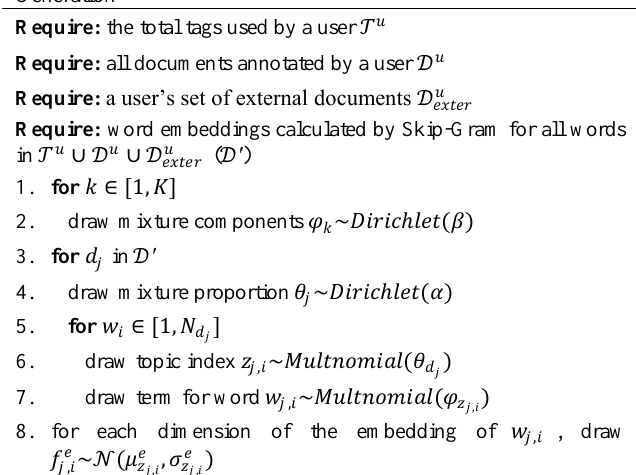
Algorithm 1 Gen erative process for Enhan ced User